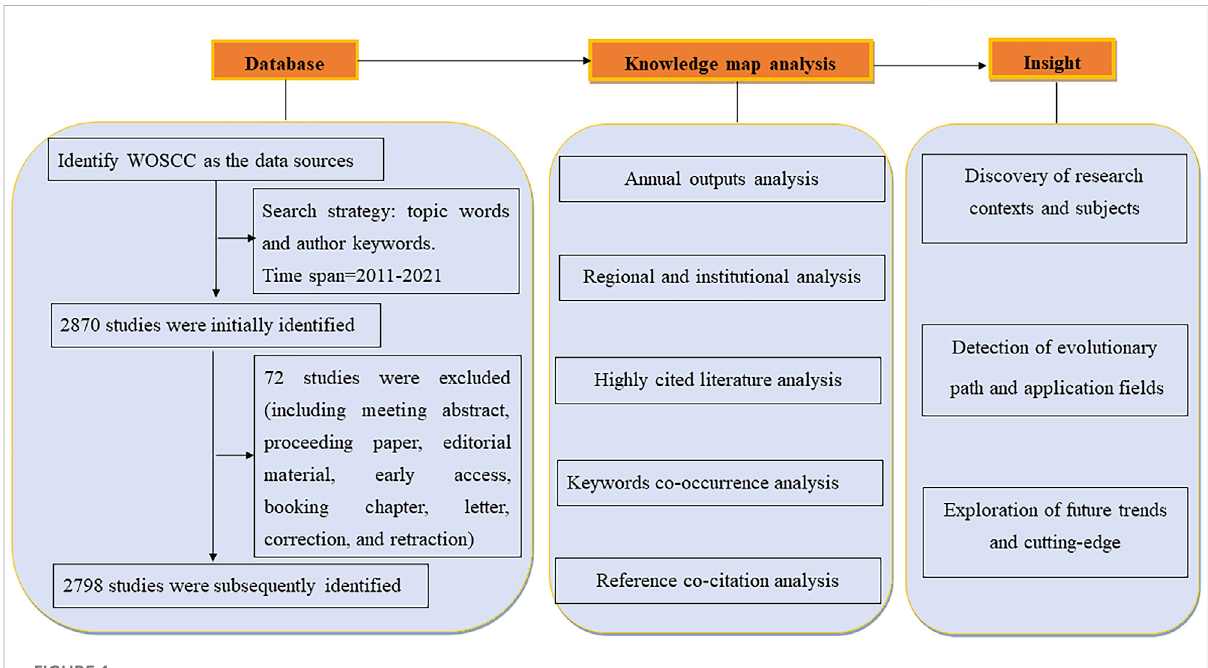
FIGURE 1 Flowchart of study selection (Preferred Reporting Items for Exercise (ET) therapy and chronic obstructive pulmonary disease (COPD).